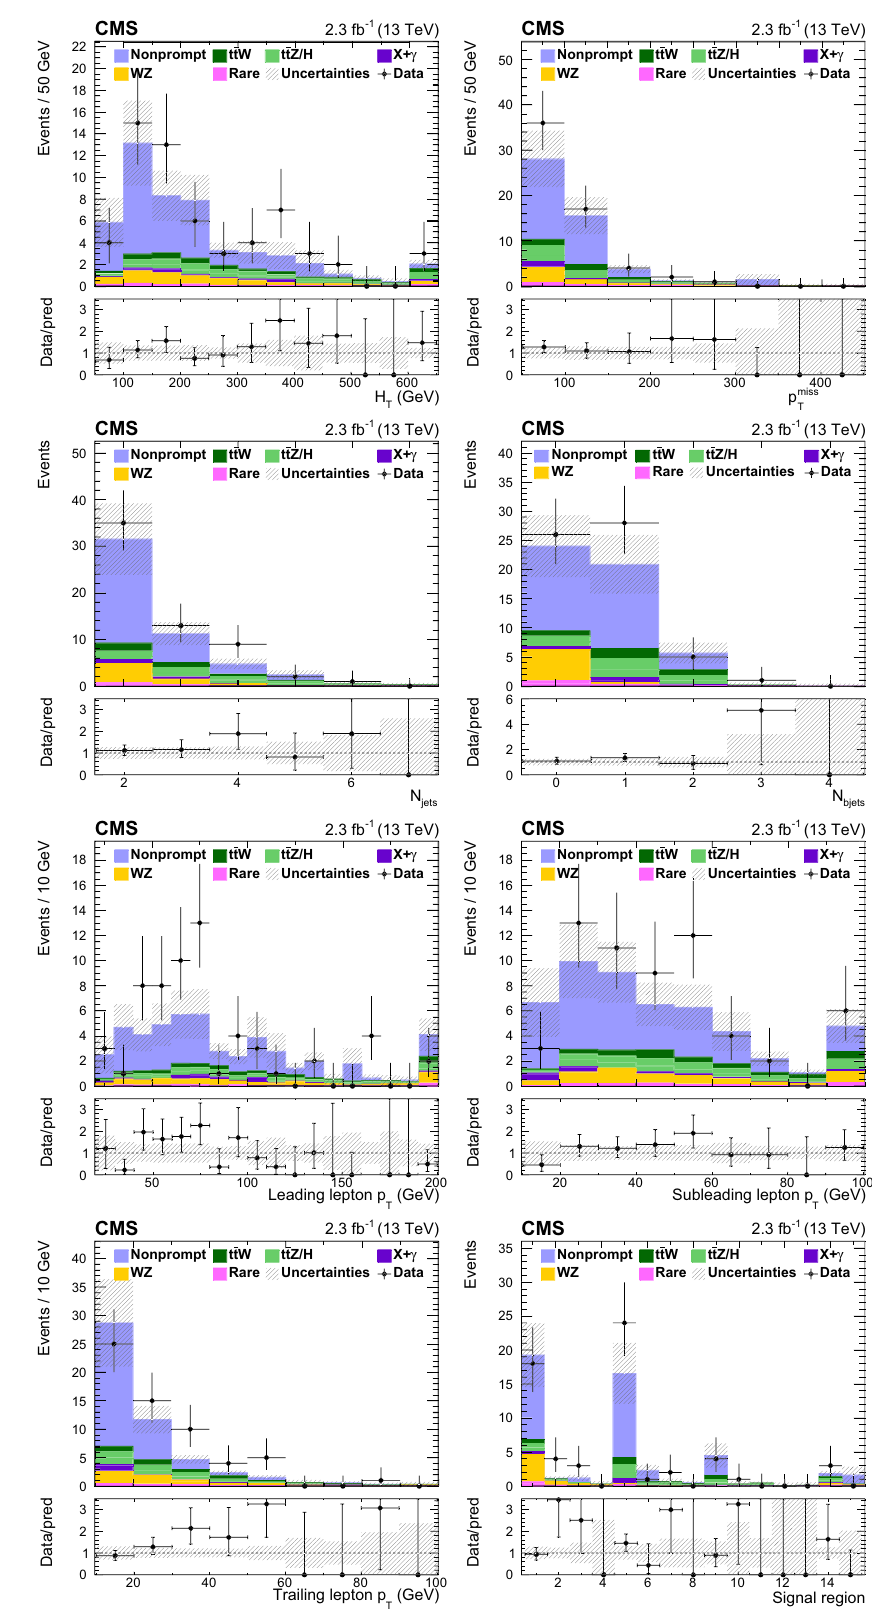
Fig. 2 Off-Z samples: from left to right, top to bottom, distributions of H T , p miss , N j , T N b , p T of leptons for the predicted backgrounds and for the data in the off-Z baseline selection region, in these plots the rightmost bin contains the overflow from counts outside the range of the plot. On the bottom-right corner the total predicted background and the number of events observed in the 15 off-Z SRs is